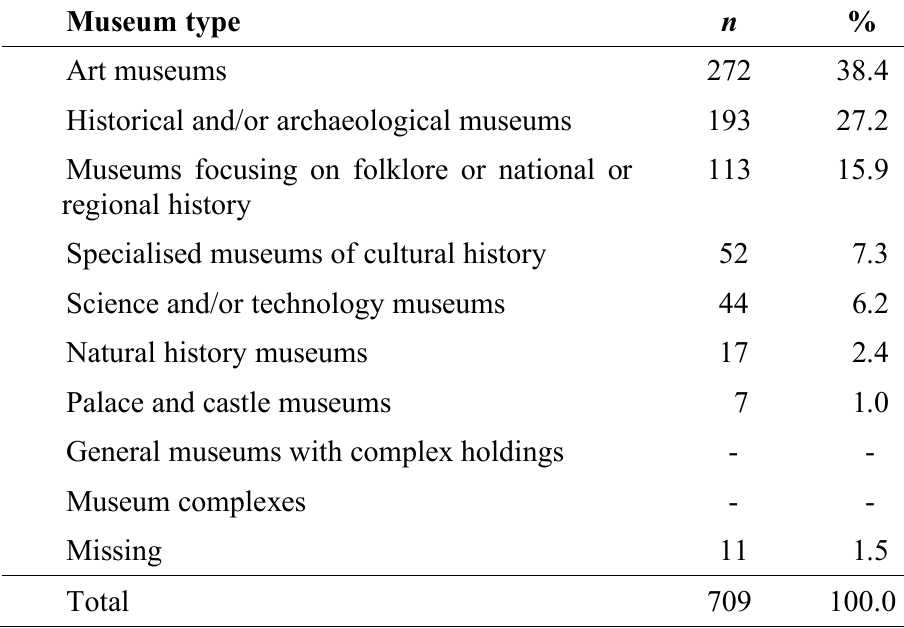
Table 1 . Overview of the total sample ( N = 709) of analysed offerings categorised according to nine possible museum